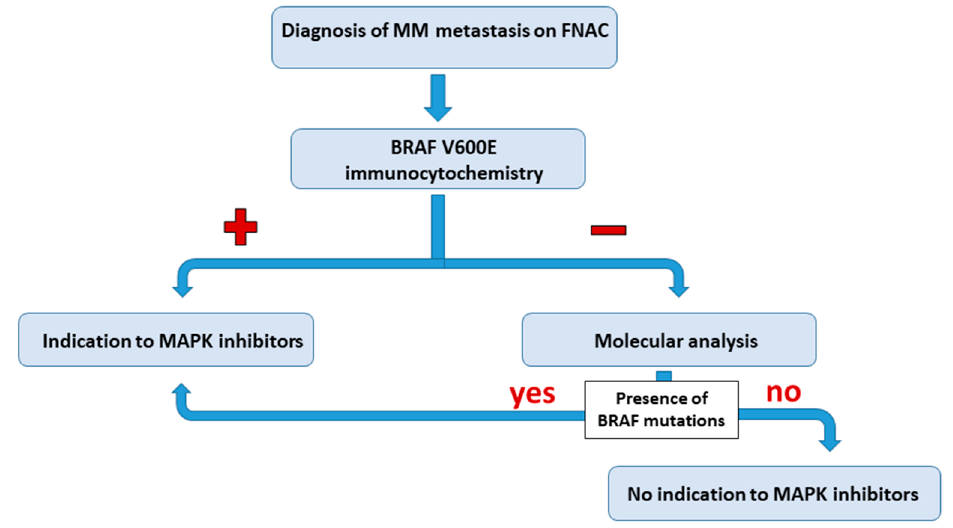
Figure 5. Proposed algorithm for the evaluation of the BRAF V600E mutation on a cytological sam-